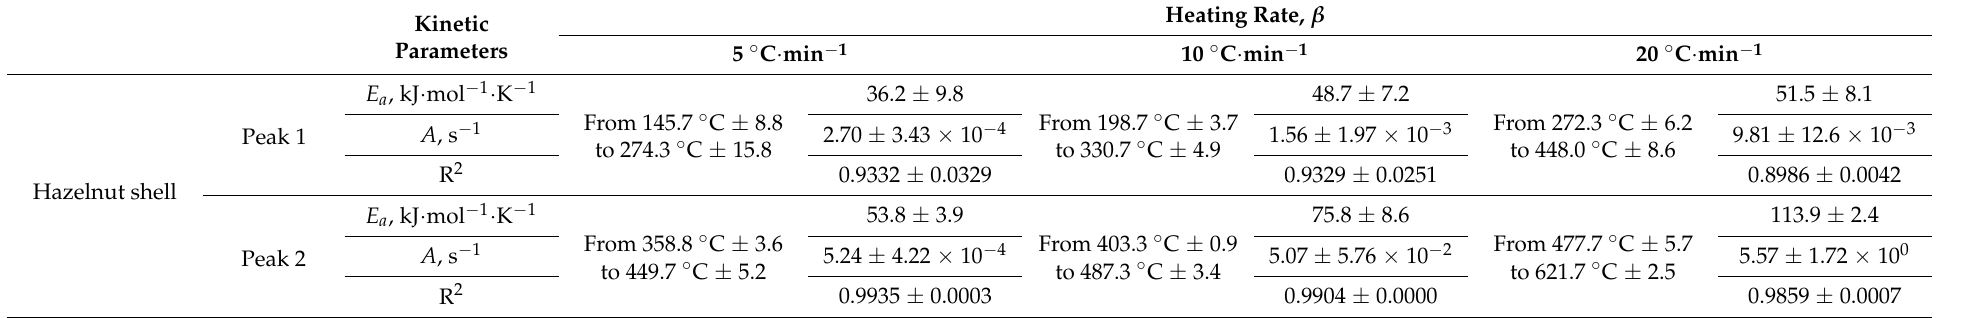
Table 6. The activation energy (Ea) [kJ · (mol · K) − 1 ] and pre-exponential factor (A) [s − 1 ] for the HS fitted peaks.